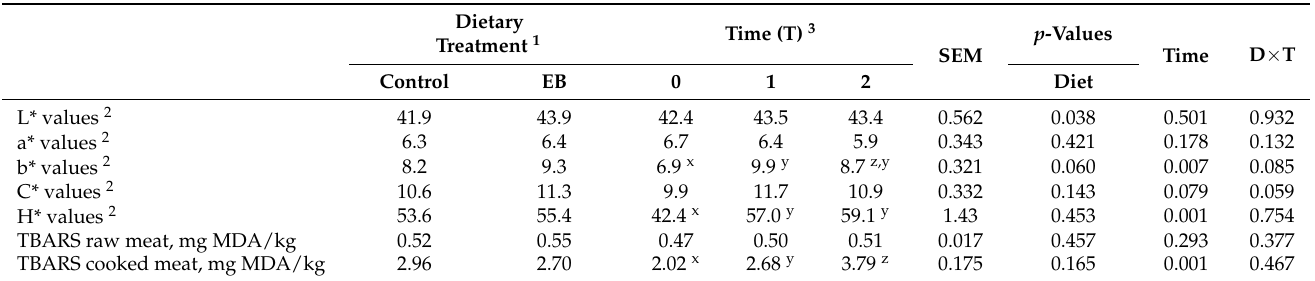
Table 7. Effect of the dietary treatment and time of refrigerated storage on raw meat color stability and lipid oxidation of raw and cooked meat.